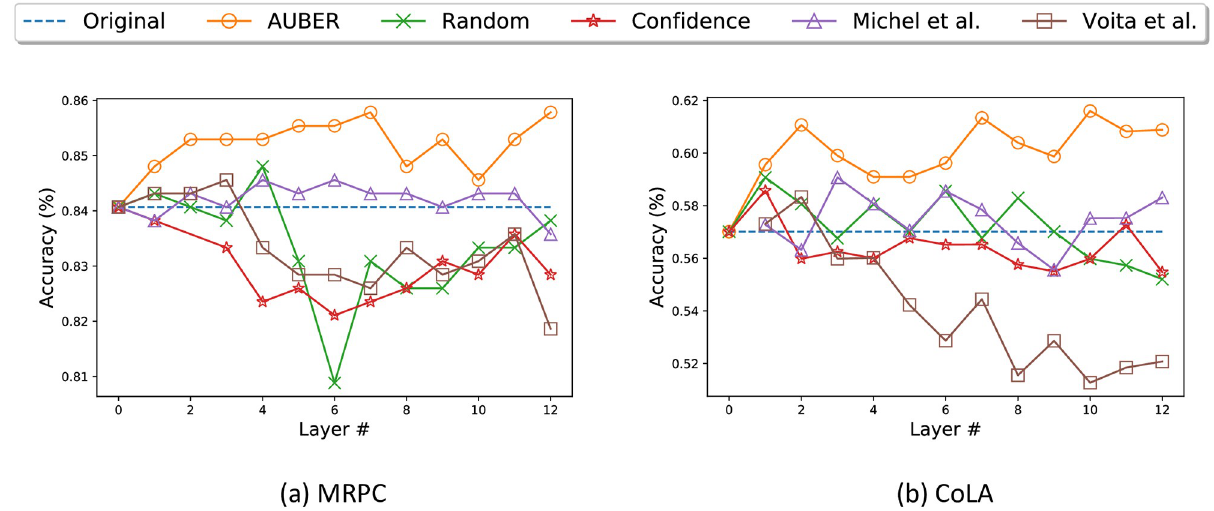
Fig 4. Performance after pruning the attention heads from each layer. AUBER consistently improves the model performance and achieves outstanding final performance, while all the other methods fail to enhance the model performance.